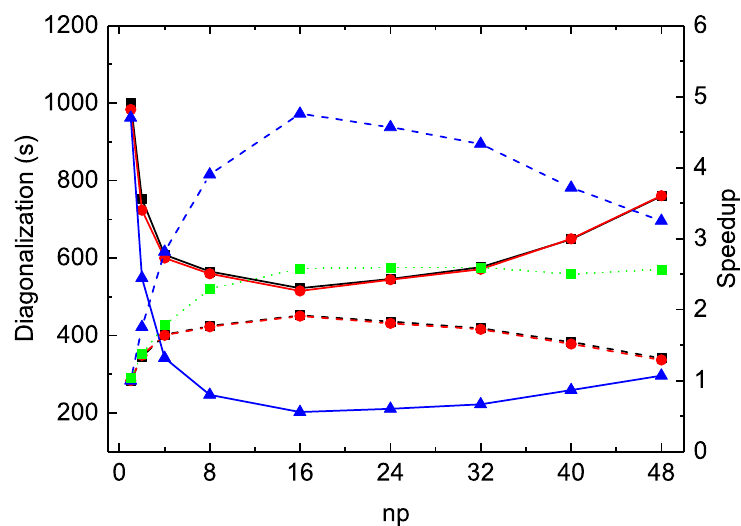
Figure 1. MPI performances of the first diagonalization in the Mg VII AS 3 -SCF calculations. Solid lines (left y axis): CPU times ( T in s) of rmcdhf_mpi (squares), rmcdhf_mem_mpi (circles), and rmcdhf_mpi_FD (triangles) codes versus the number of MPI processes ( np ) (also listed in the first “SetH&Diag” line for each code of Table 2). Dashed lines (right y axis): speed-up factors for the three codes, with the same corresponding symbols, estimated from the ratios of T ( np = 1 ) to others. Dotted line (right y axis) (square symbols): speed-up of rmcdhf_mpi_FD relative to rmcdhf_mpi , calculated as T ( rmcdhf_mpi )/ T ( rmcdhf_mpi_FD ).